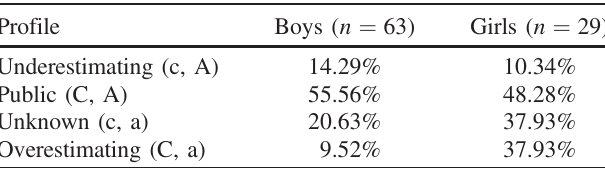
TABLE II. Percent of population in profile by